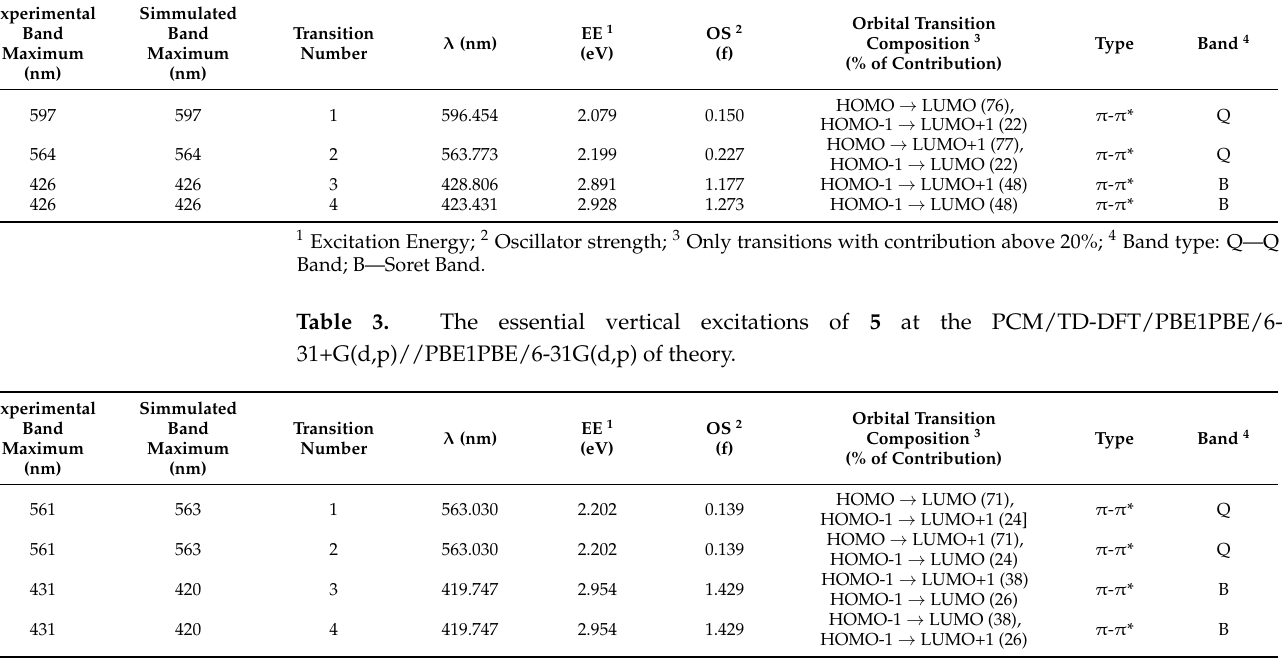
The essential vertical excitations of 4 at the PCM/TD-DFT/PBE1PBE/6-